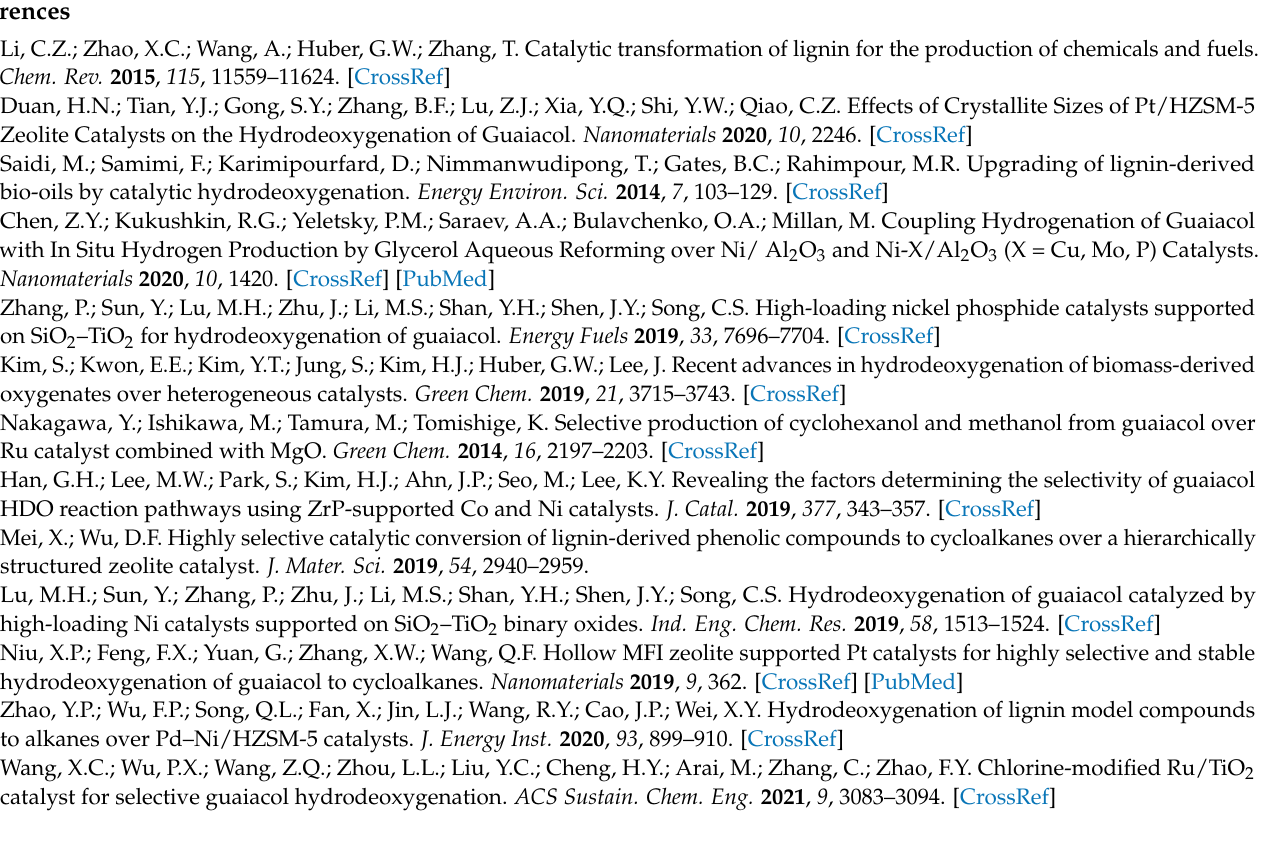
Figure S1: The full-scan XPS survey spectrum of the Co 2.5 /rGO catalyst; Figure S2: Characterization results of the Co 2.5 /Gr catalyst: (a) TEM image and particle size distribution, (b) HAADF-STEM im- age; Figure S3: The NH 3 -TPD result of the CoO x powder; Table S1: Catalysts for hydrodeoxygenation of guaiacol to cyclohexanol; Table S2: Co-based catalysts used in hydrodeoxygenation of guaiacol. References [8,9,13–32] are cited in the Supplementary